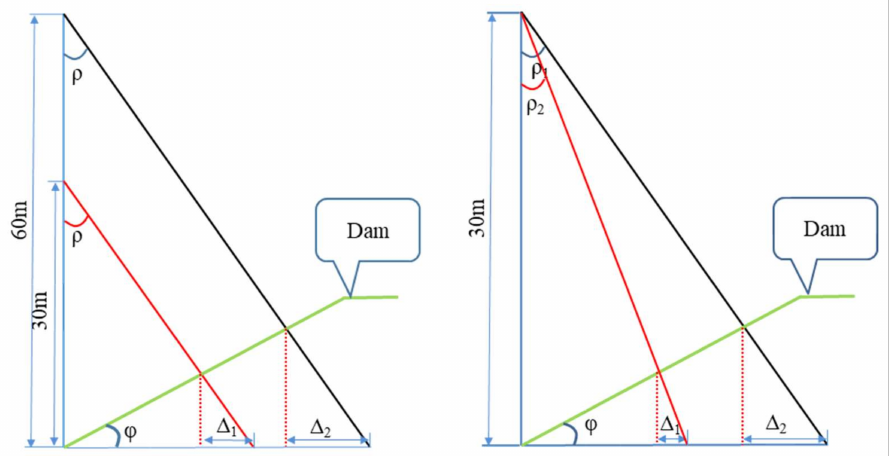
Figure 8. Variation of point error for different flight altitudes ( left ) and camera angles ( right